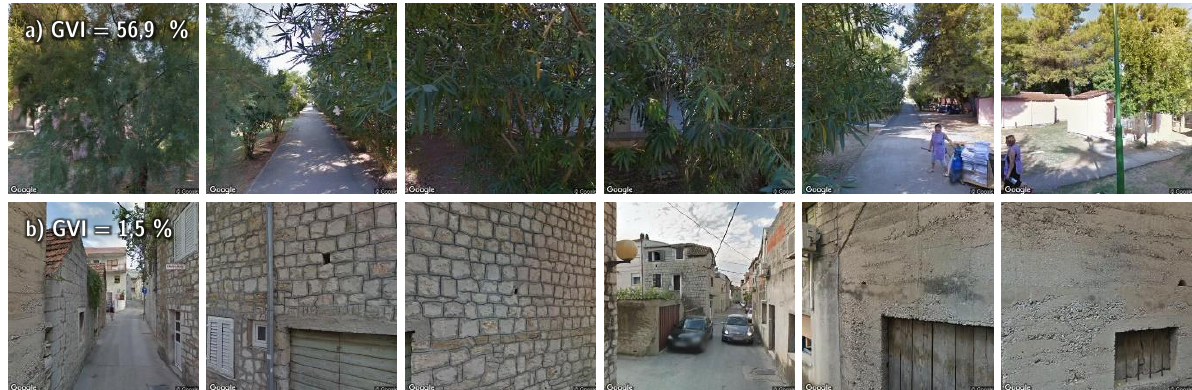
Figure 4. GSV 360° stripes with (a) maximum and (b) minimum GVI value within the study area